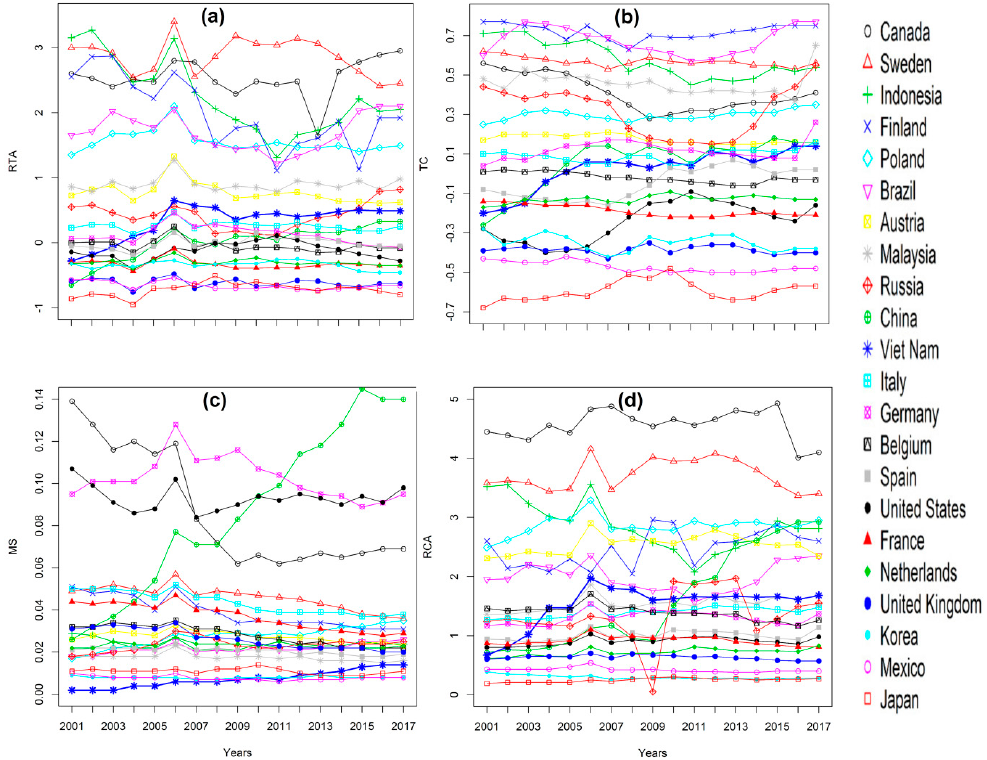
Figure 4. Changes in international competitiveness index values for selected countries for 2001–2017: ( a ) Relative trade advantage index (RTA); ( b ) Trade competitiveness index (TC); ( c ) Market share index (MS) and ( d ) Revealed comparative advantage index (RCA).